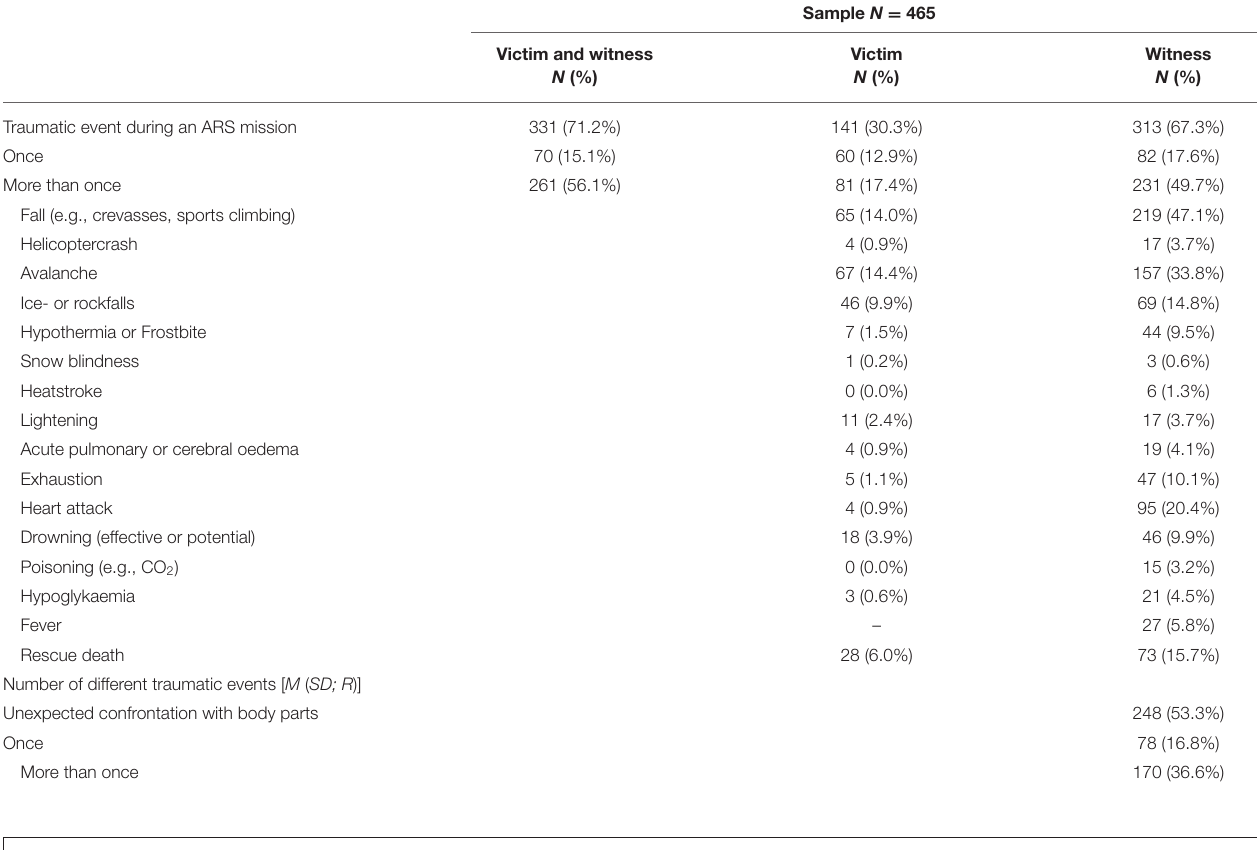
TABLE 2 | Traumatic events experienced by Swiss mountain rescuers ( N =